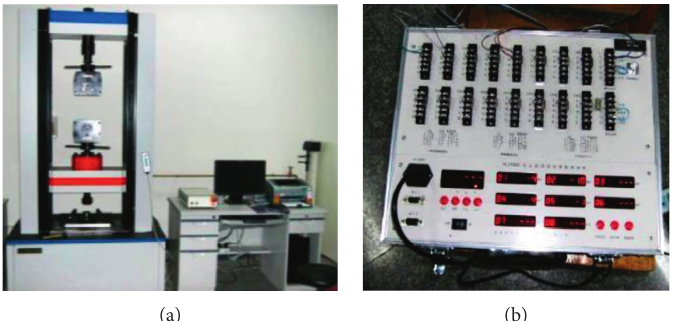
Figure 2: Uniaxial compression test devices for coal and rock samples. (a) DNS200 electronic universal testing machine. (b) XL2158C stress and strain integrated parameter tester.